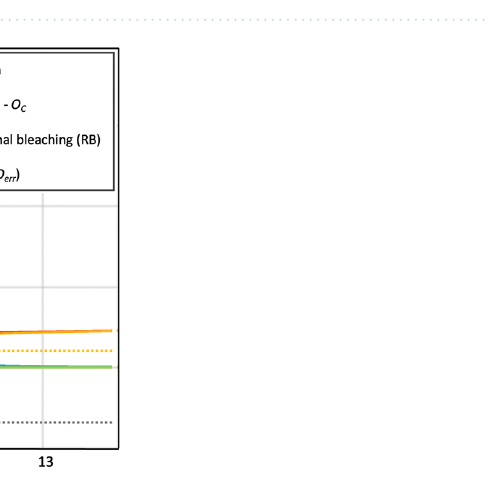
Figure 2. Boxplots for the mean (cross; ± 1 SE) amplitude, decay constant and offset of 500 bootstraps, for both groups, at each kLux level.